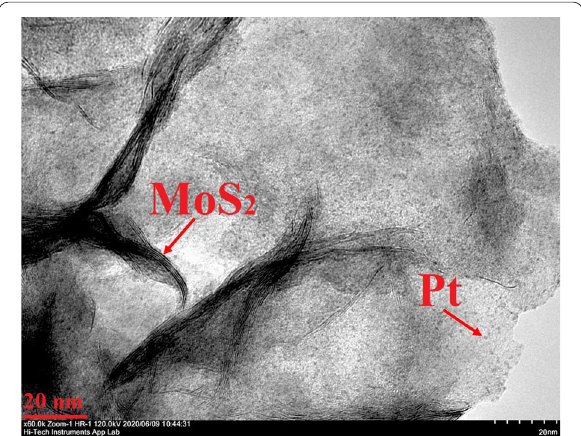
Fig. 5 High magnification TEM image of Pt/Mo-90